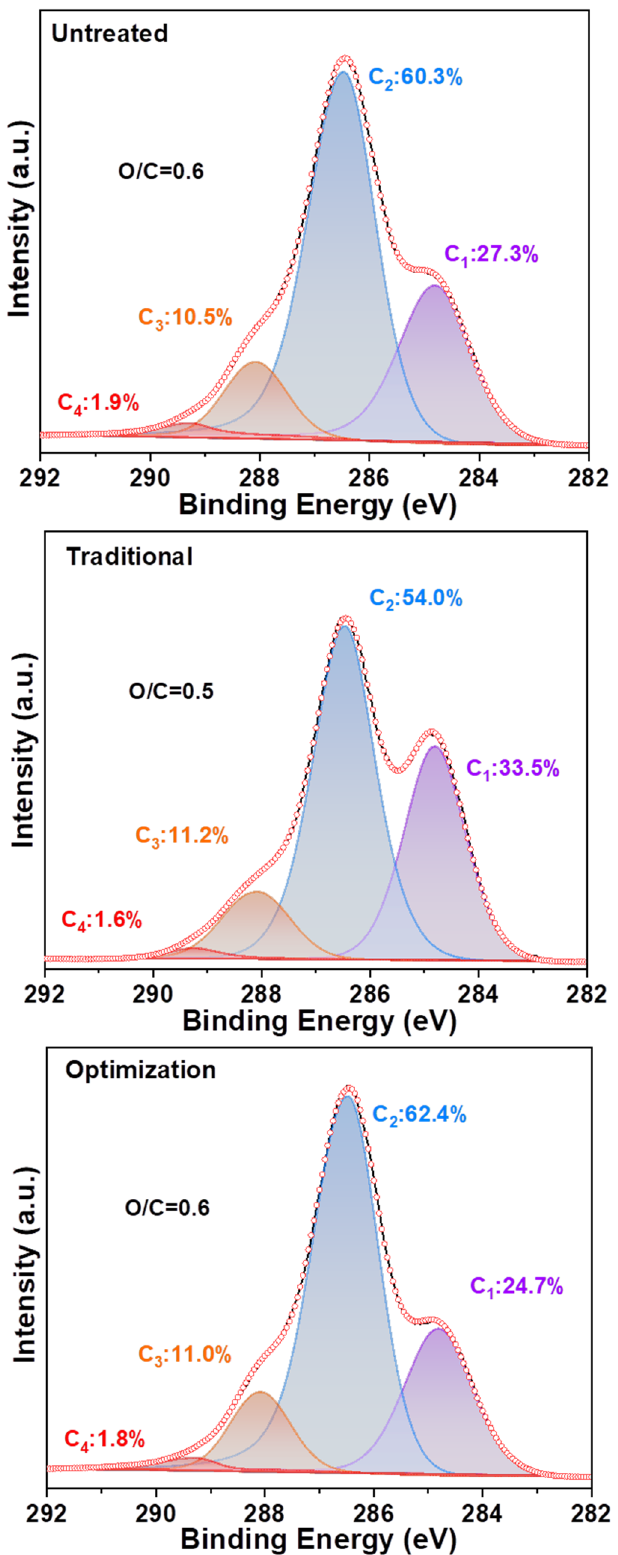
Figure 8. Carbon distribution and oxygen/carbon ratio on the fiber surface of eucalyptus.